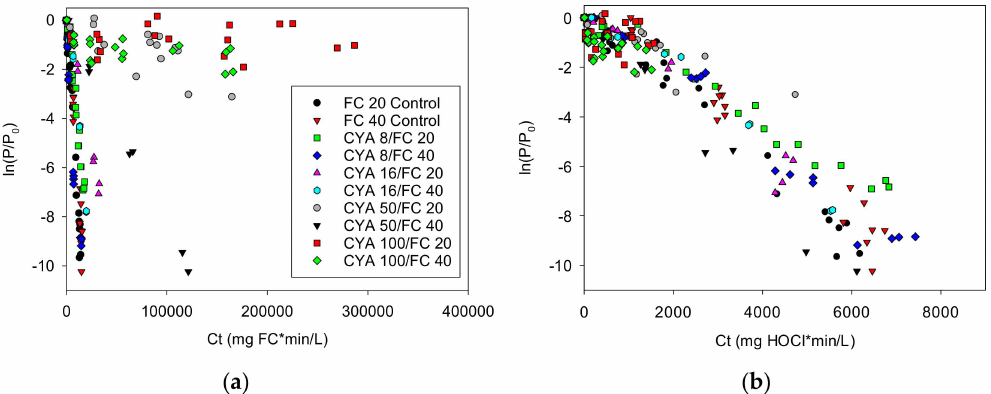
Figure 4. Relationship between log reduction ln(P / P 0 ) and Ct for Cryptosporidium parvum , where C represents the concentration of ( a ) free chlorine or ( b ) hypochlorous acid: The HOCl concentrations were calculated using values for free chlorine, pH, CYA, and temperature from Murphy [9]. With the Murphy data, it is clear that HOCl, with a correlation coe ffi cient of − 0.96, correlates very well with inactivation of Cryptosporidium , while FC, with a correlation coe ffi cient of − 0.061, does not. Further supporting data may be found in the Supplementary Materials